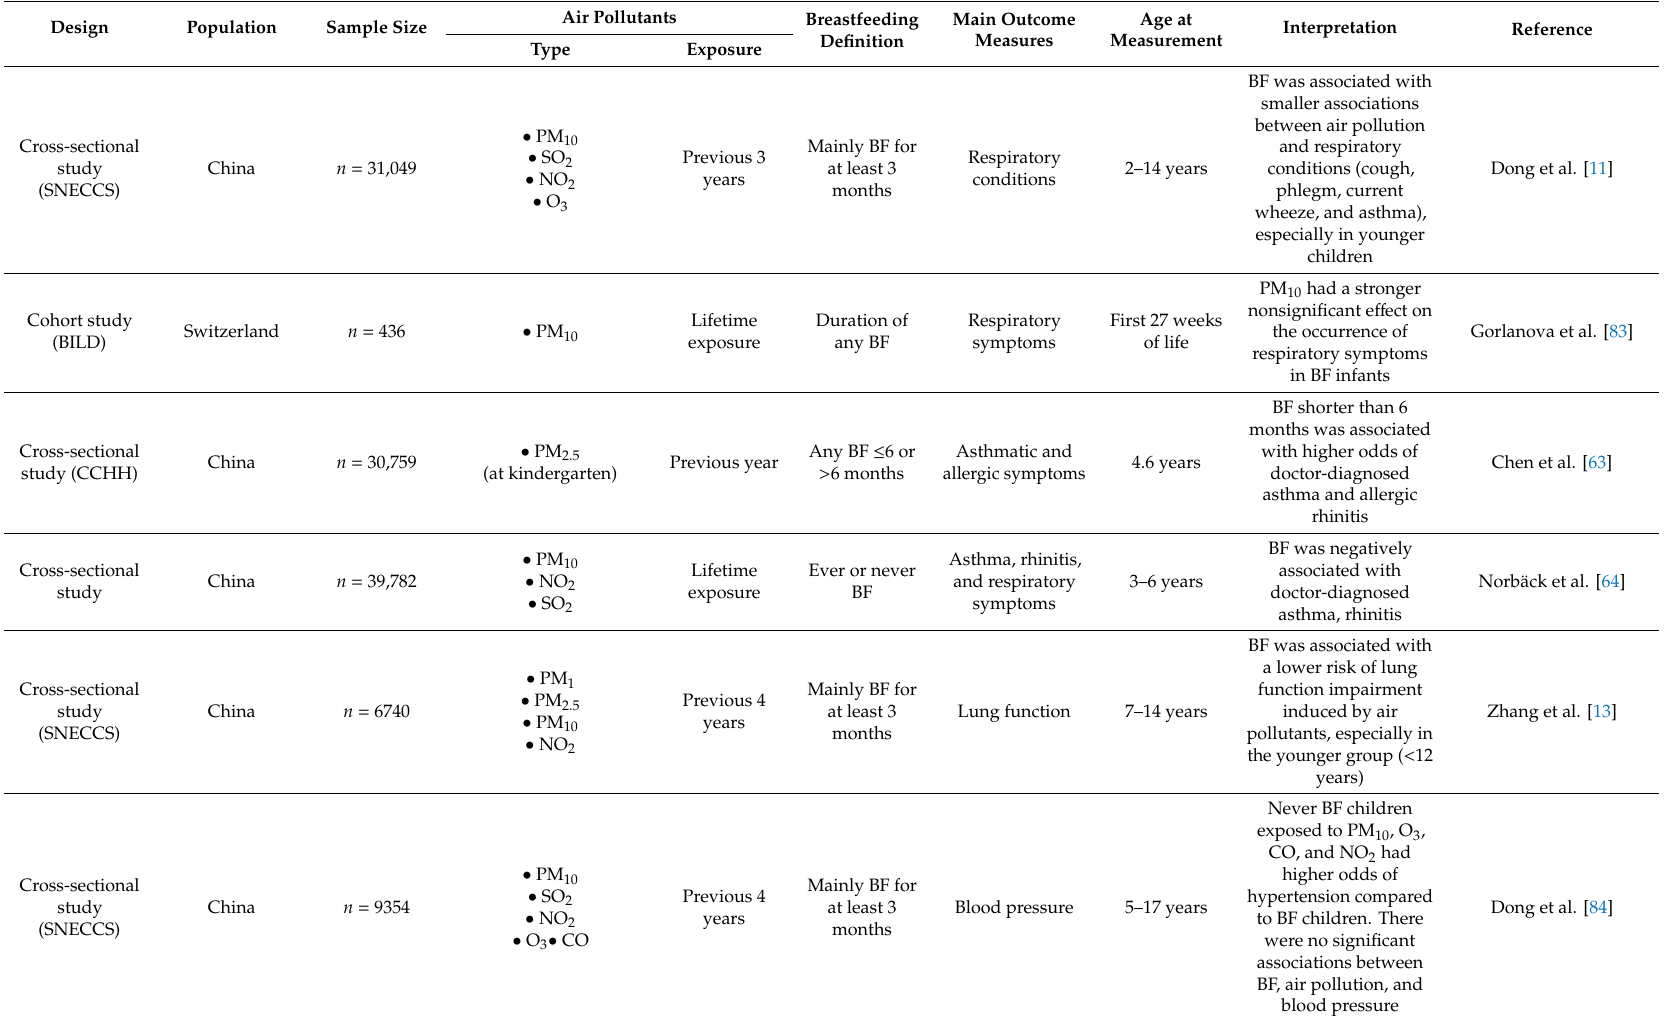
Table 3. Studies investigating the influence of breastfeeding on health e ff ects induced by outdoor air pollution exposure in the first 1000 days of